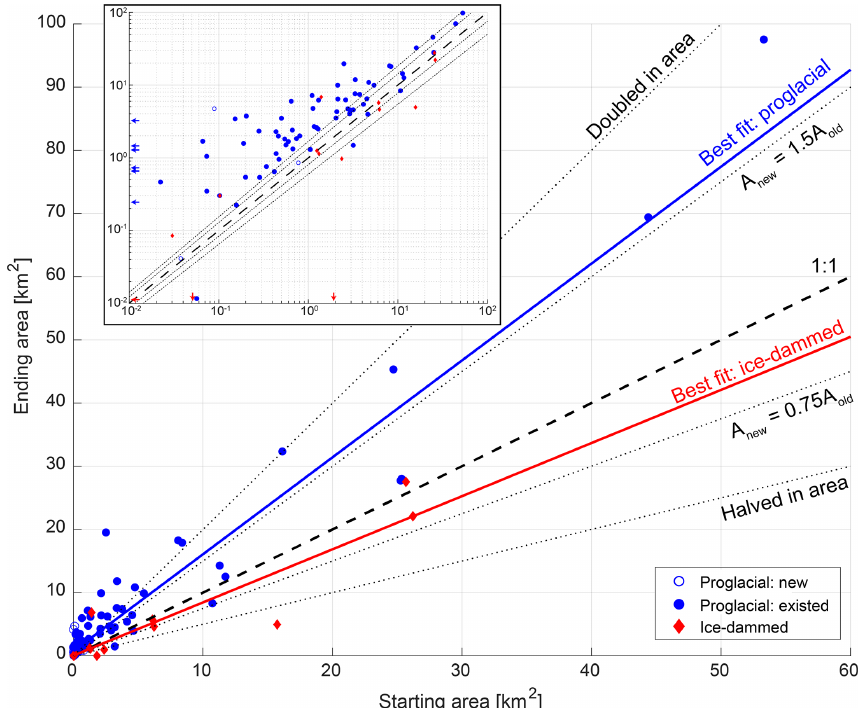
Figure 3. Ice-marginal lake area at the start (horizontal axis) and end (vertical axis) of the study period. Proglacial lakes that existed for the entire study period are shown as filled blue circles, while proglacial lakes that appeared in that time (new lakes) are shown as unfilled symbols. Red diamonds depict ice-dammed lakes. The dashed line shows 1 : 1 (i.e., lakes with constant area), while the dotted lines show various levels of relative area change. The blue (red) solid lines show the Theil–Sen estimator line of best fit to proglacial (ice-dammed) lakes. The inset shows the same data in log–log space to better display the behavior of small lakes.